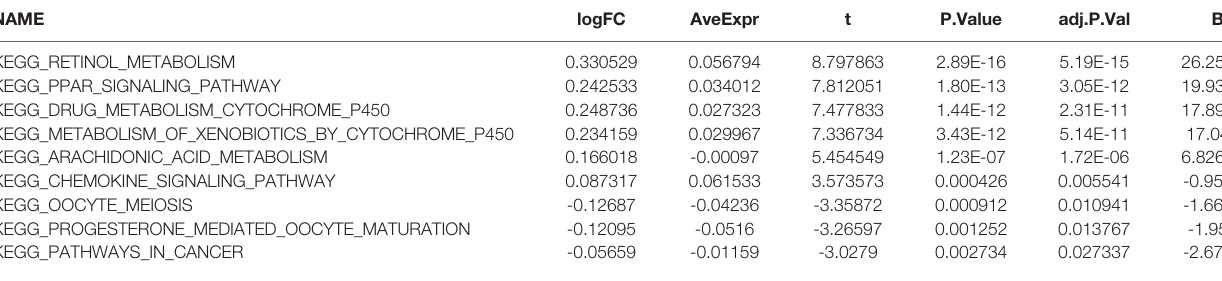
TABLE 5 | Gene Set Variation Analysis between high- and low risk groups in the ICGC cohort.